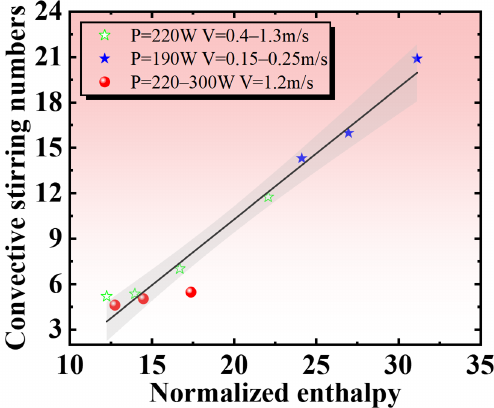
Figure 9. The convective stirring numbers of the molten pool at various scanning rates and laser powers.